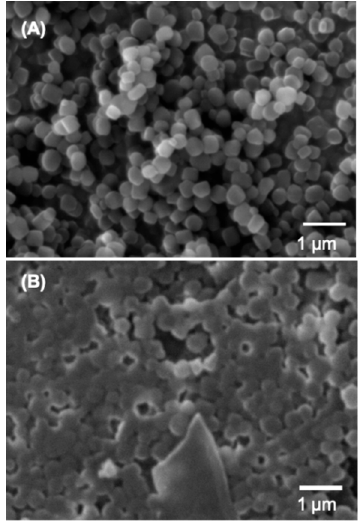
Figure 1. SEM images of fabricated mesoporous silica nanoparticles. ( A ) SEM image of unmodified MSNs. ( B ) SEM image of PTBAEMA-b-PEGMEMA attached to MSNs.